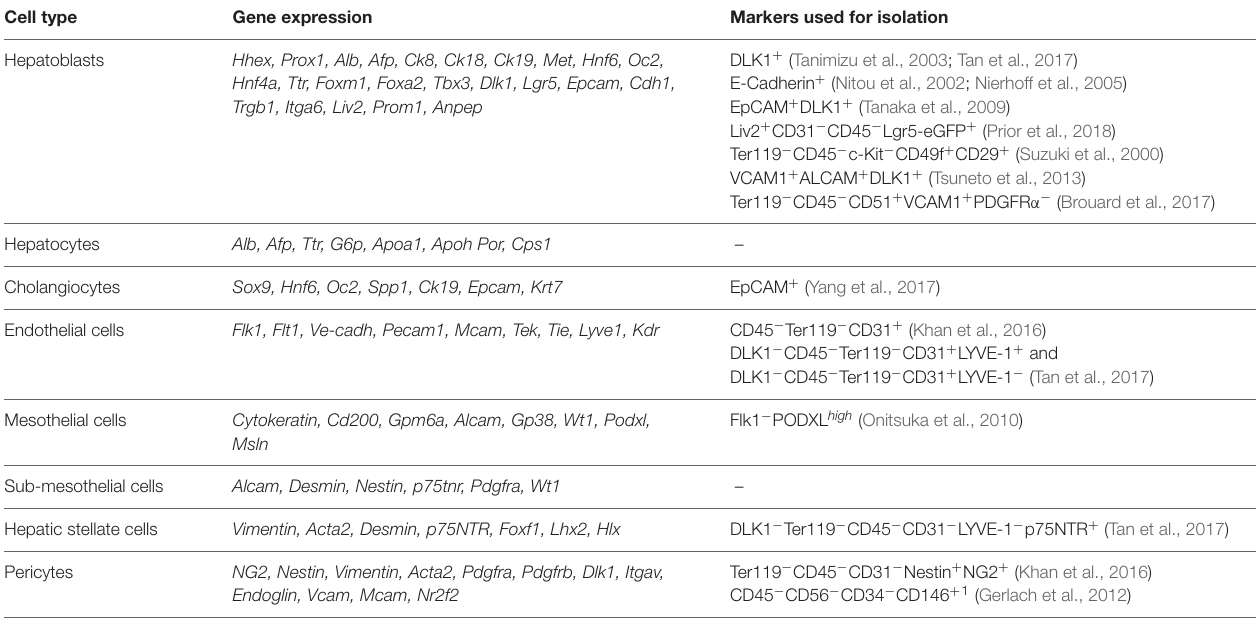
TABLE 1 | Fetal liver non-hematopoietic compartment: cell types and associated